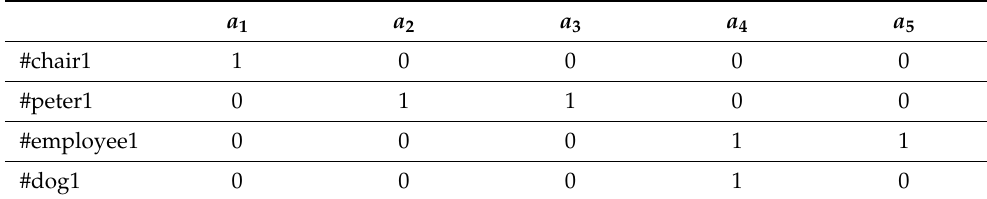
Table 1. T1: Generated context